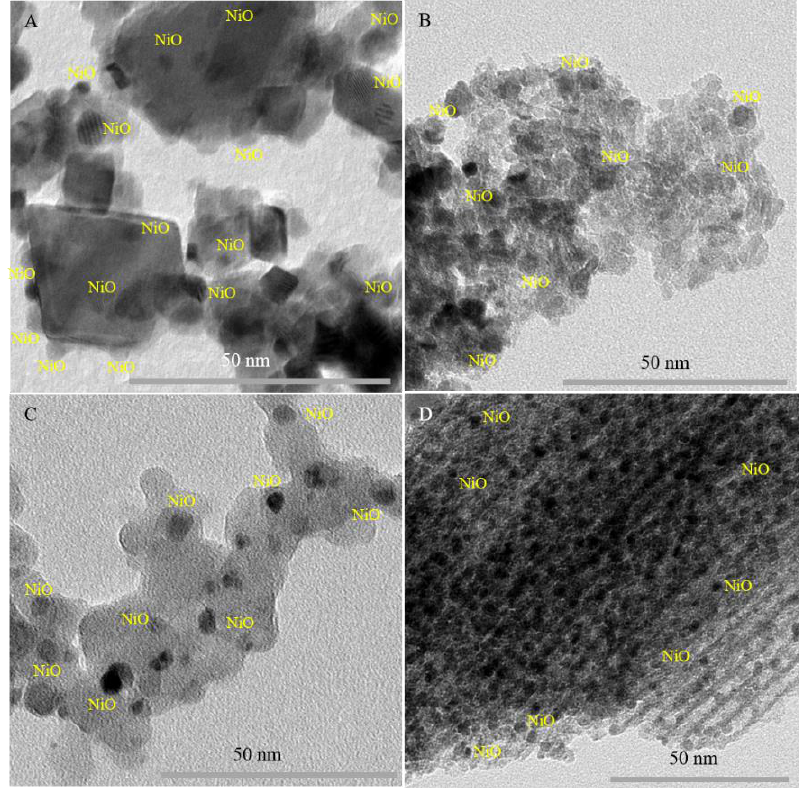
Figure 4. TEM images of ( A ) Ni/CeO 2 -CA, ( B ) Ni/Al 2 O 3 -CA ( C ) Ni/SiO 2 -CA and ( D ) Ni/SBA-15-CA catalysts.